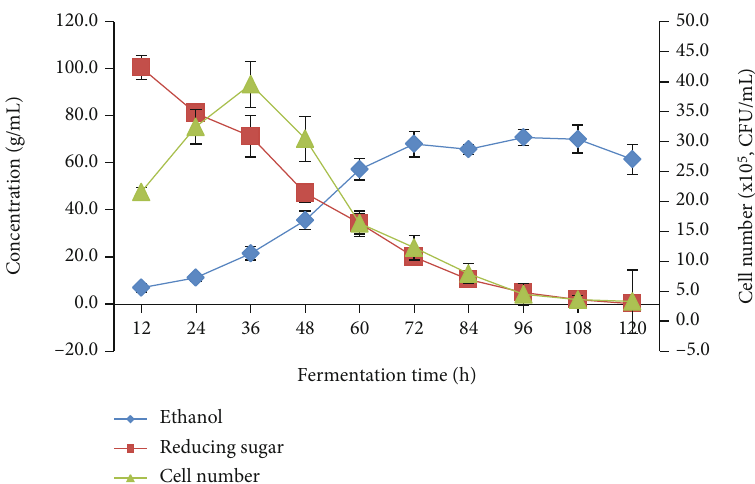
Figure 1: 10 L fermentation pro fi le of ethanol production, reducing sugar consumption and cell growth of yeast from ground black pepper fermented medium. Data correspond to mean ( ± SD) for three independent experiments. RT: 0.00 - 31.00